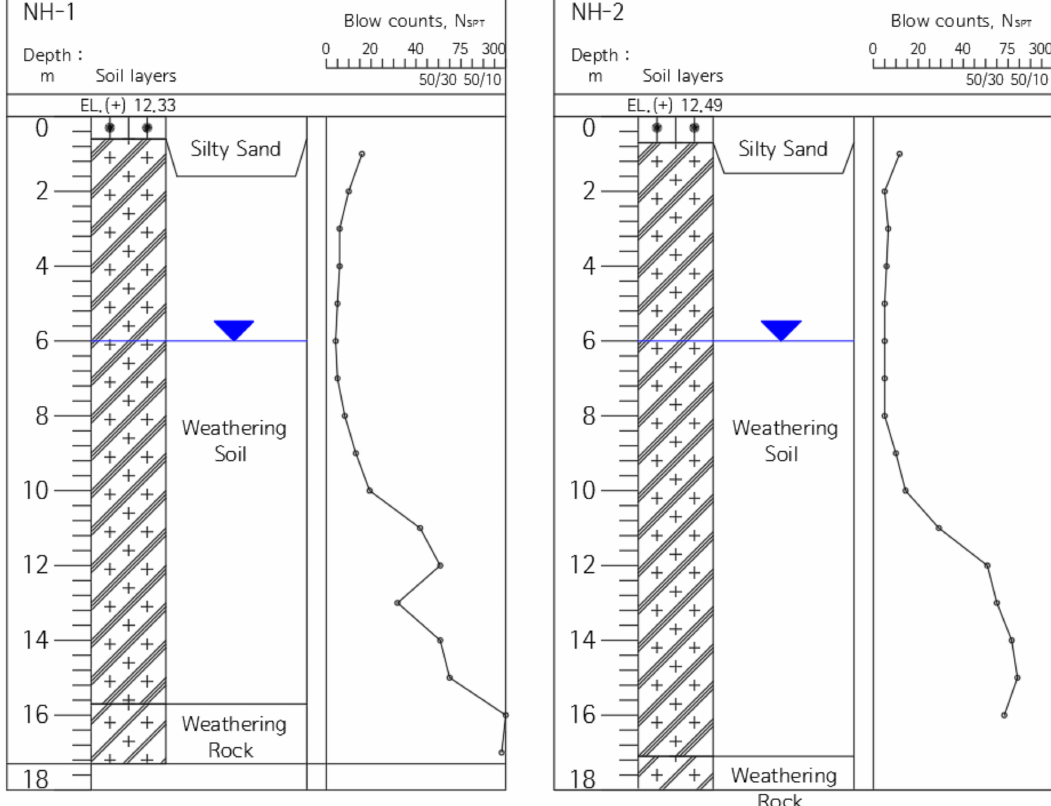
Figure 4. Sectional view of the Site-1